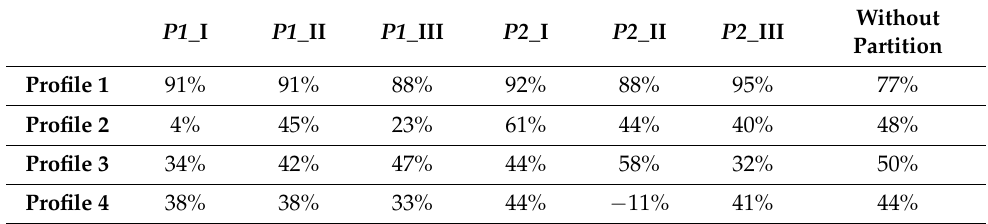
Figure 13. The amount of energy stored and delivered to the tank. Table 6. Energy efficiency of the system.